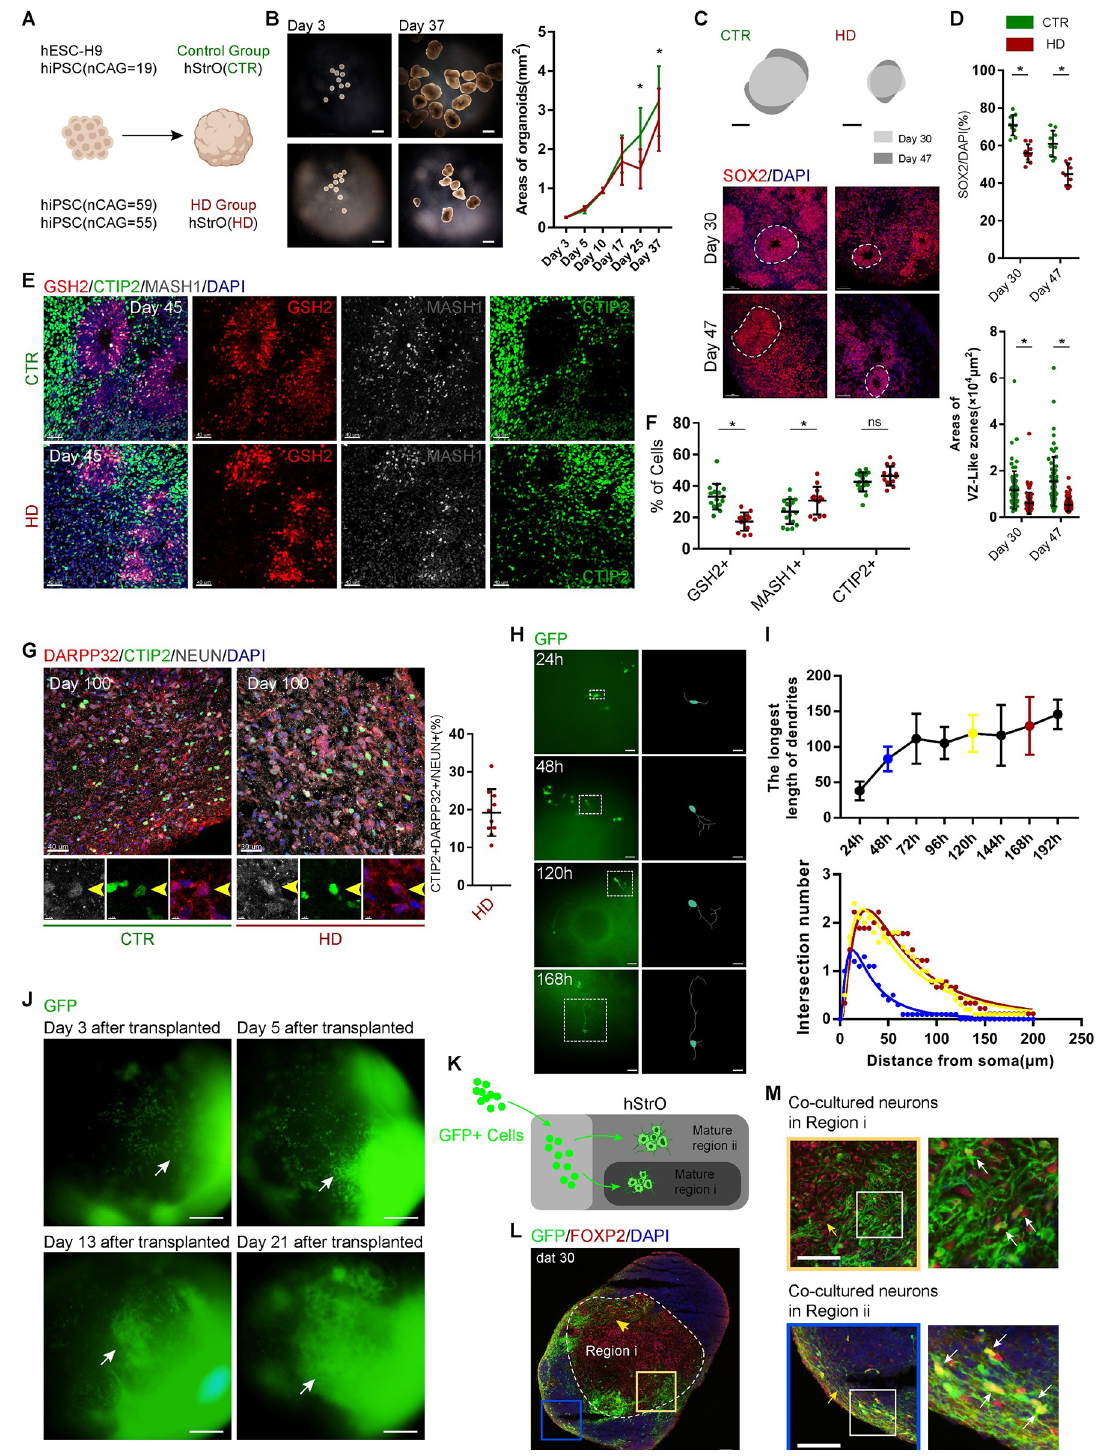
Fig 6. hStrOs model the striatal development of Huntington’s disease. (A) Schematic of generating CTR hStrOs and HD hStrOs. (B) Morphology of CTR and HD hStrOs after 3 days and 37 days of culture. Scale bar, 1 mm. In culture, the quantity of organoid size in the area from Day 3 to Day 37. Data, mean ± SD. Organoids, n > 10. One-way ANOVA. � , P < 0.05. (C, D) Immunostaining for SOX2 antibody on Day 45 CTR and HD hStrOs. Dashed lines marked the rosette in the hStrO. Quantifying SOX2+ cells and rosette (also termed VZ-like zones) areas in hStrOs. Organoids, n = 9–10. One-way ANOVA. � , P < 0.05. Scale bar, 50 μ m. (E, F)